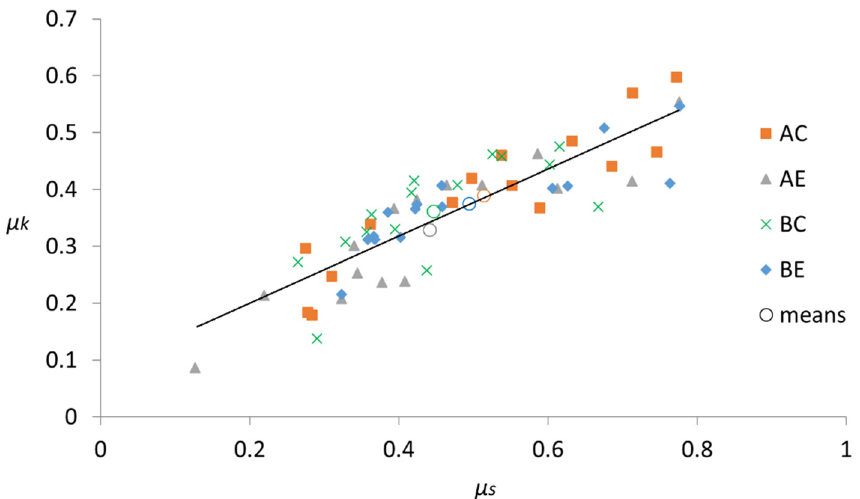
Figure 9. Relationships between the values of µ k and µ s for the different timber-to-timber friction pairs, as well as the mean value for each case (indicated by a circle of the referred color) and the fitted line ( µ k = 0.58 µ s + 0.09).